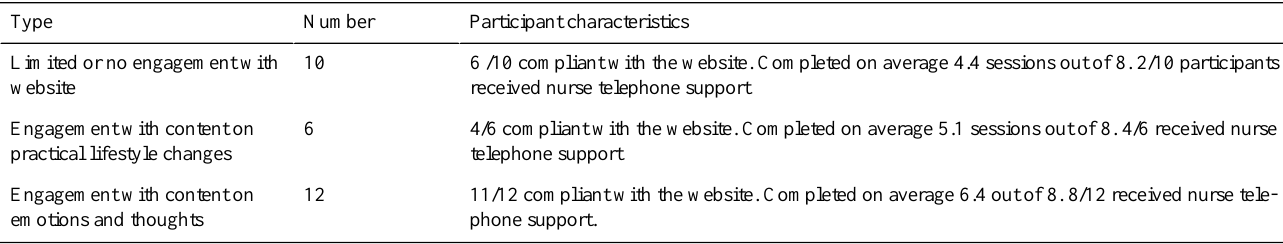
Table 2. Participant characteristics for each of the three types of engagement identified. Participant characteristicsNumberType